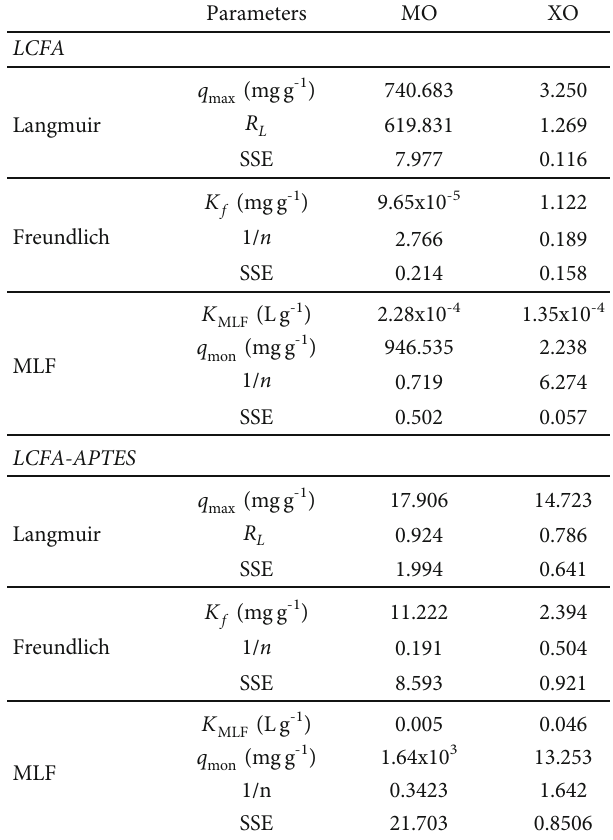
Table 4: Adsorption isotherm parameters of MO and XO removed by LCFA and LCFA-APTES.